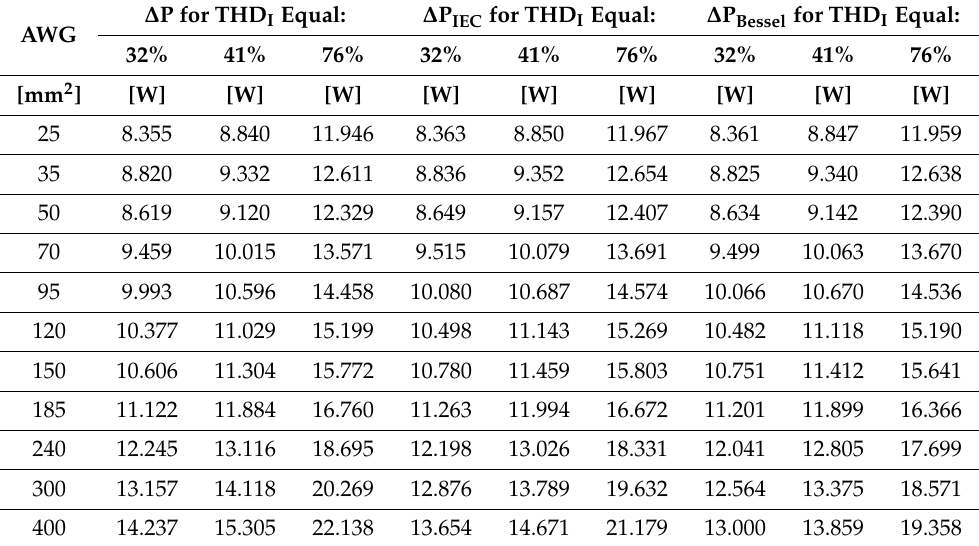
Table 2. The cable power losses for the 50% rated cable current. ∆ P for THD I AWG